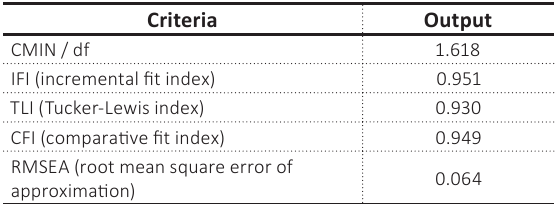
Table 7. Goodness-of-fit results